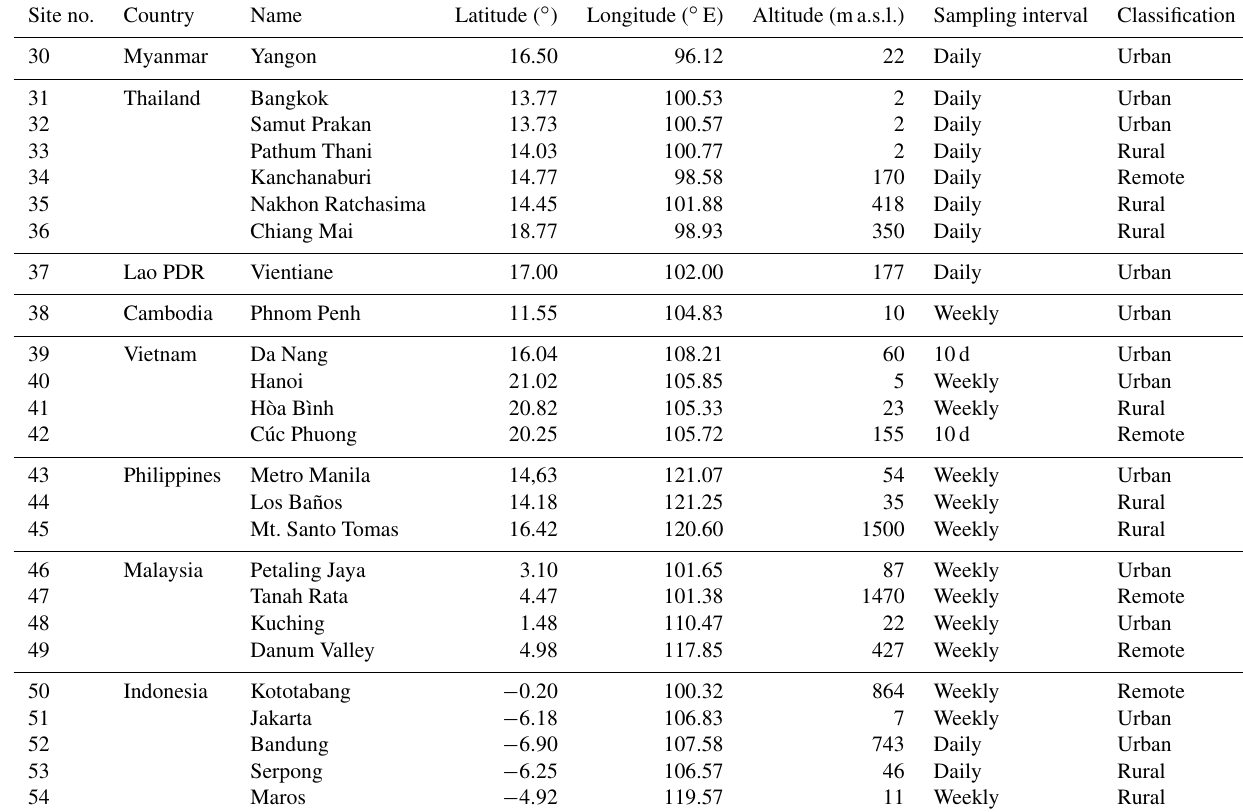
Table 2. Information of 25 EANET observation sites located in southeast Asia. Site